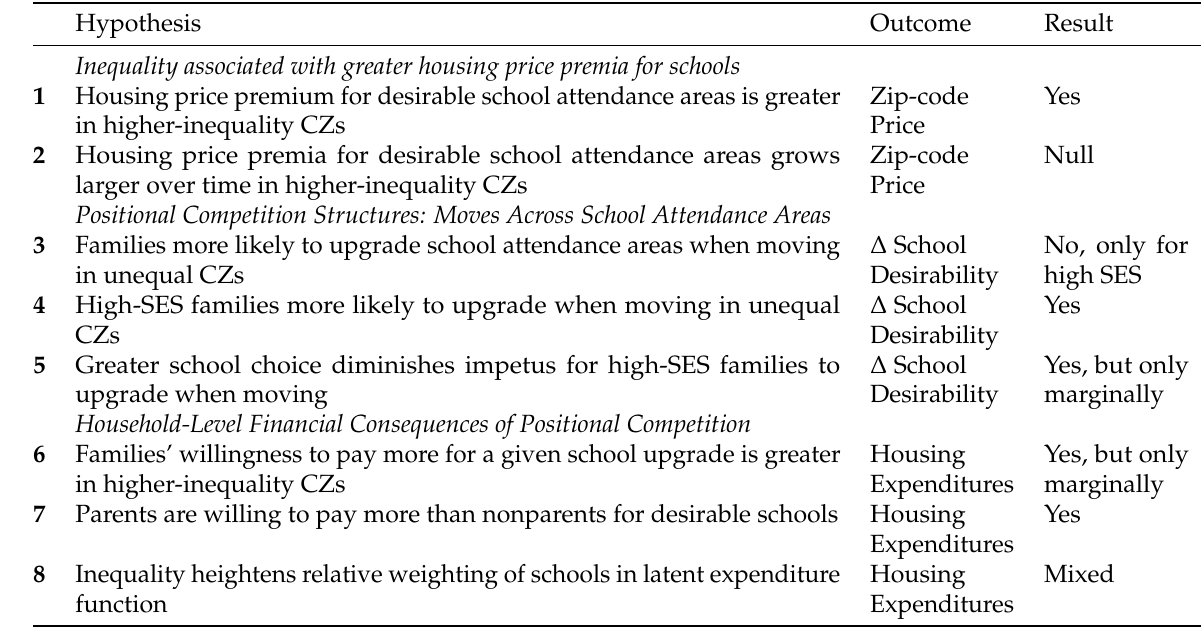
Table 4: Summary of hypotheses and results. Hypothesis Outcome Result Inequality associated with greater housing price premia for schools 1 in higher-inequality CZs